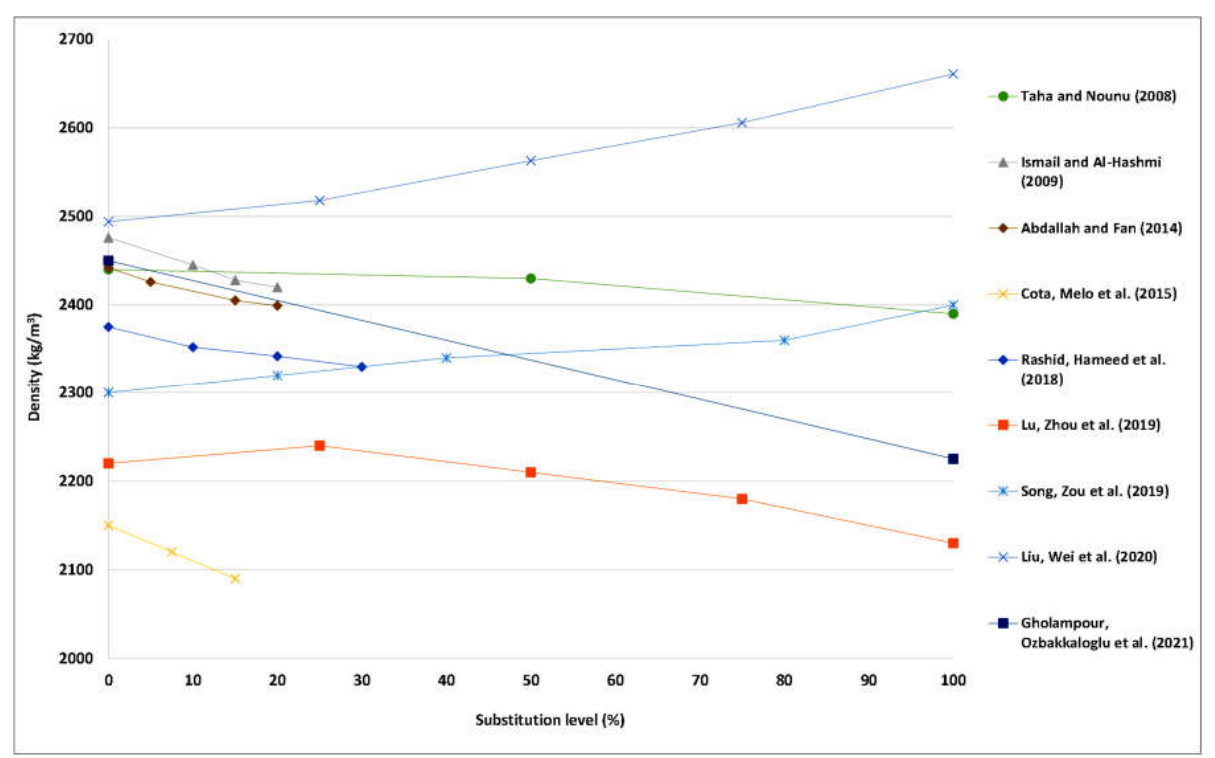
Figure 2. Bulk density of concrete with various content of WG. Adapted from references [56,65,80,83,84,87,105–107].